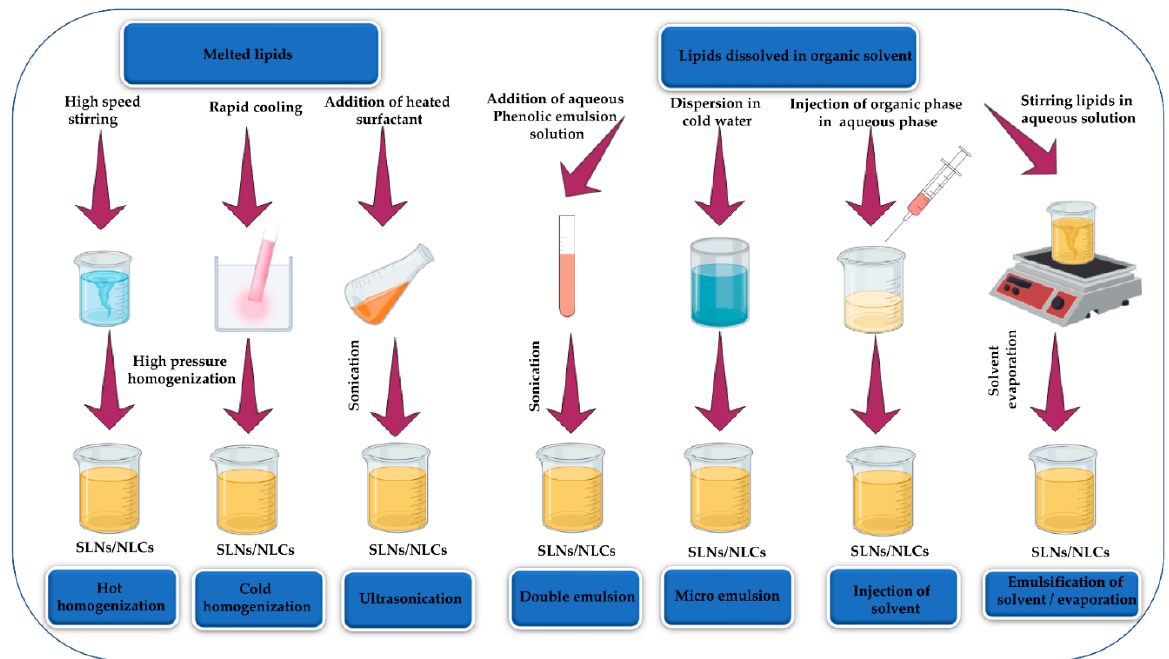
Figure 9. Scheme showing the most common techniques used for the preparation of SLNs and NLCs, involving (i) hot and cold homogenization, (ii) ultrasonication, (iii) double and micro emulsion, (iv) solvent injection, and (v) emulsifica- tion/evaporation methods.